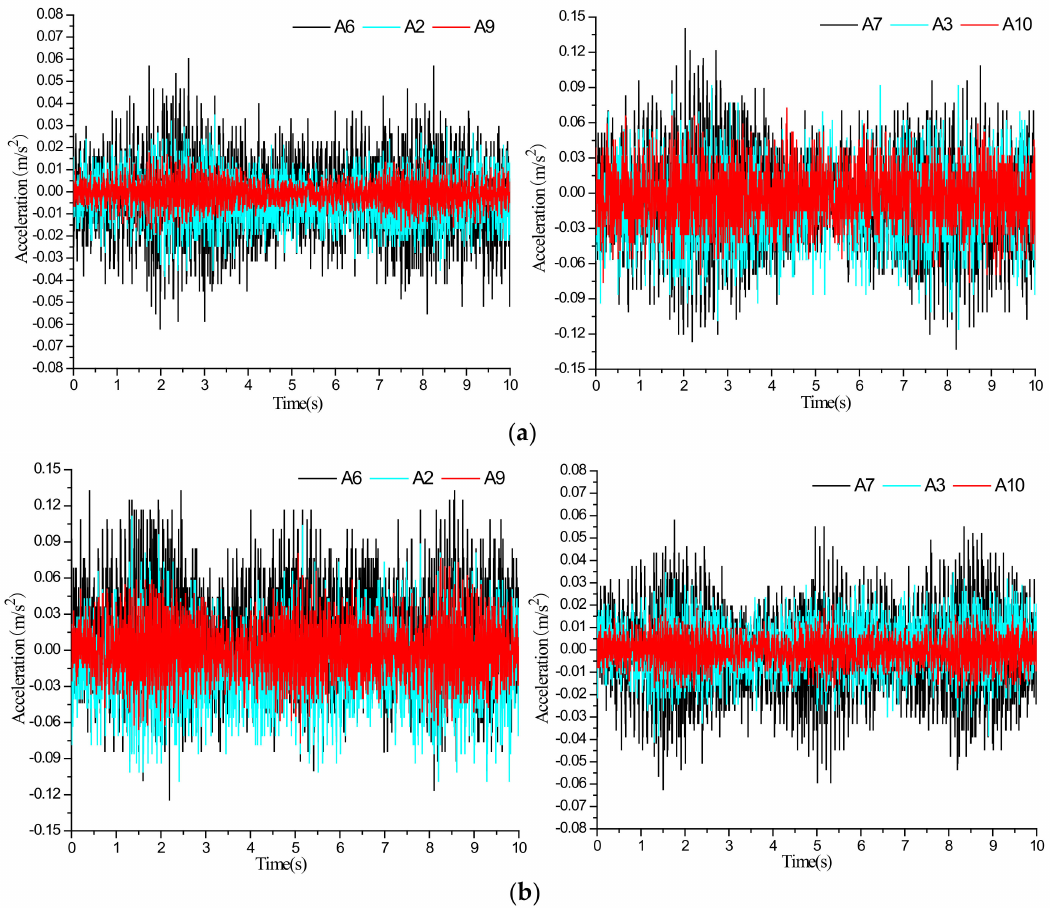
Figure 8. Acceleration time series of the two-section subway tunnel under the scenario of inactive ground fissure: ( a ) vibration exciter at 60 cm; ( b ) vibration exciter at 100